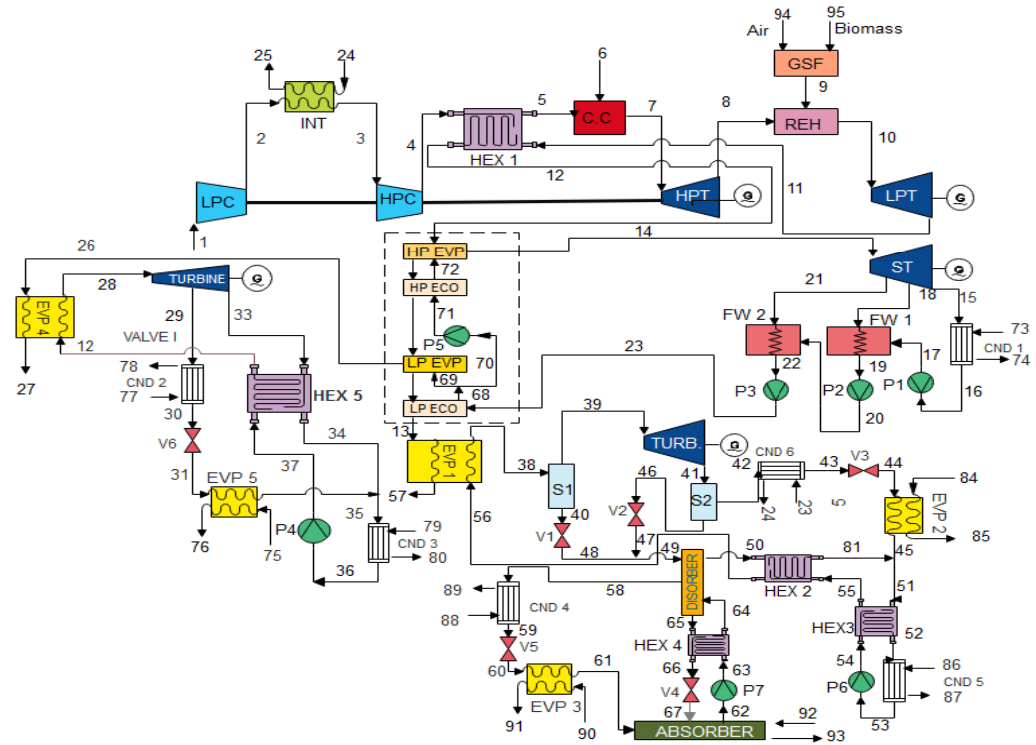
Figure 1. The proposed integrated multi-generation plant. Note: Numbers represent inlet and exit states.